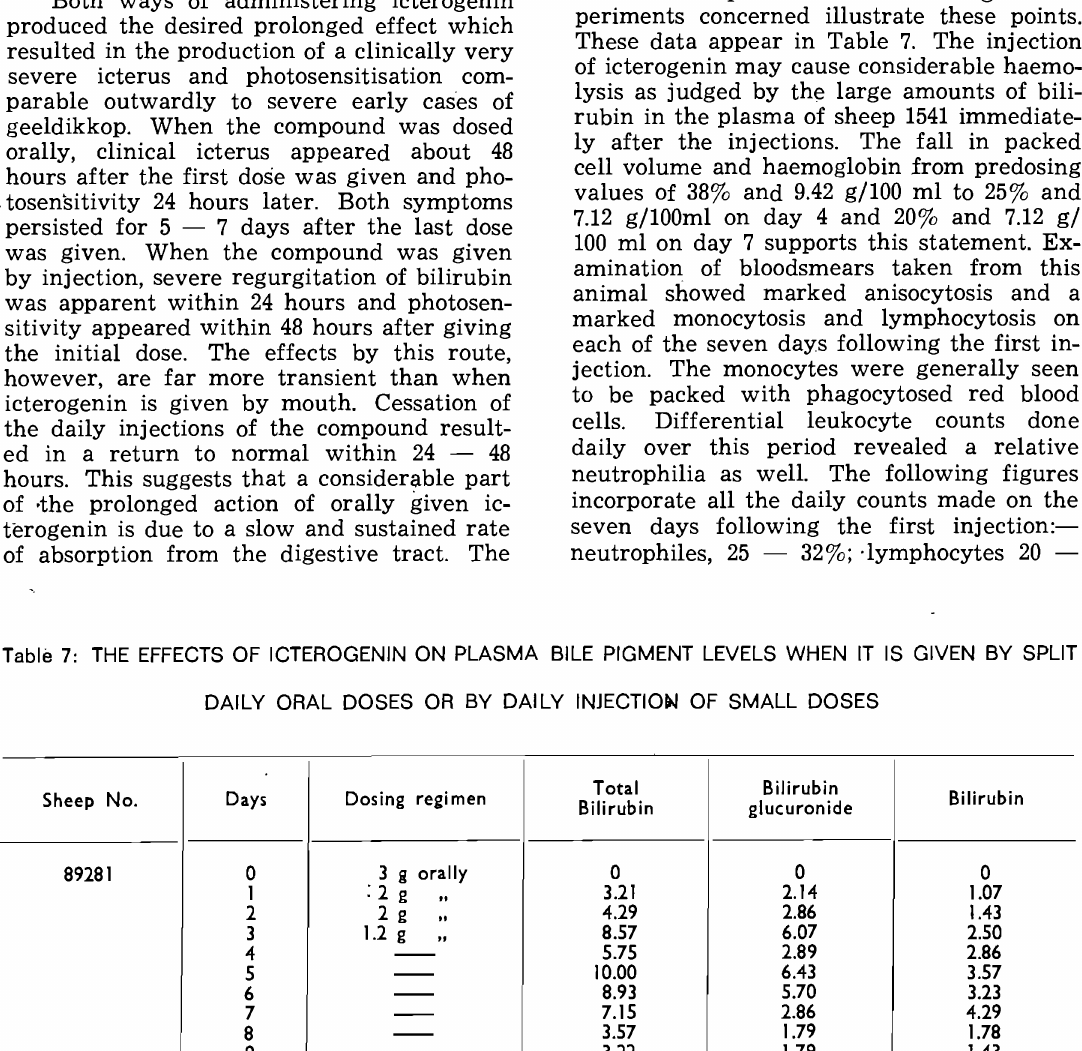
Table 7: THE EFFECTS OF ICTEROGENIN ON PLASMA BILE PIGMENT LEVELS WHEN IT IS GIVEN BY SPLIT DAILY ORAL DOSES OR BY DAILY INJECTIOW OF SMALL DOSES